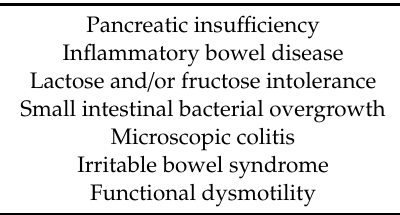
Table 1. Conditions associated with coeliac disease that should be considered as a cause for persisting symptoms in coeliac patients